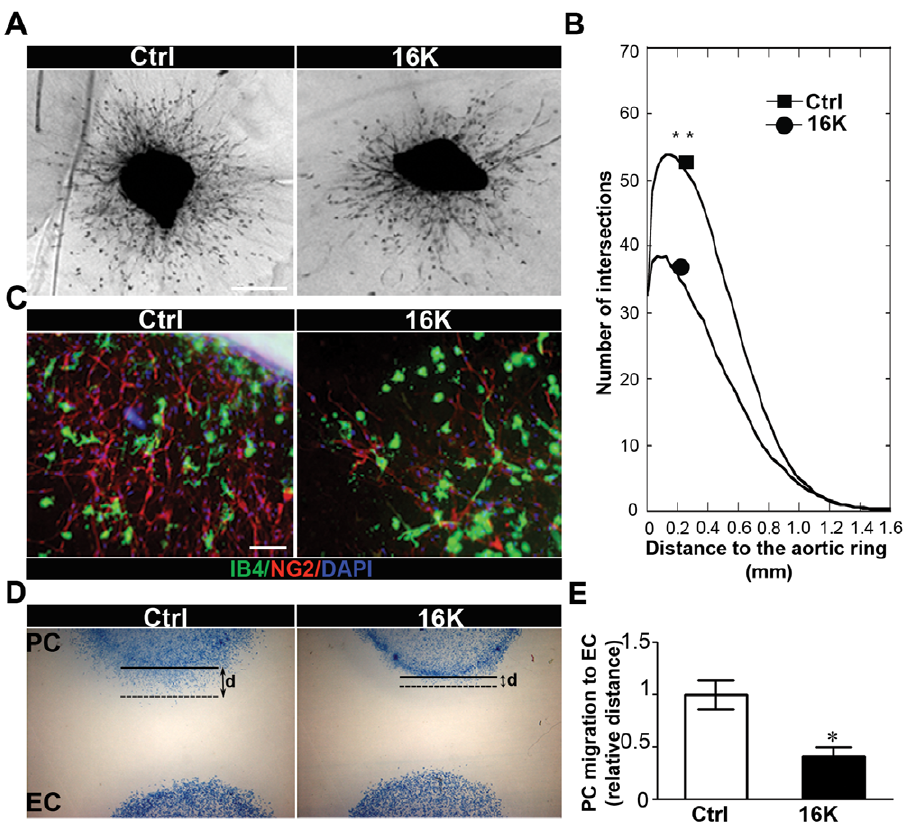
Figure 3. 16K hPRL inhibits pericyte outgrowth in an aortic ring assay and pericyte migration towards endothelial cells. (A) Photomicrographs of mouse aortic ring cultured in collagen for 9 days and incubated without specific treatment (Ctrl) or under 16K hPRL treatment (16K). Data representative of at least 2 independent experiments are shown. Bar , 1 mm. (B) Quantification of migrating cell distribution around the aortic ring performed by computerized image analysis. Cell distribution is defined as the number of intersections between spreading cells and a grid of concentric rings, plotted as a function of the distance to the aortic fragment. Each curve is a mean of the cell network distribution obtained by averaging at least 5 individual distributions generated for each experimental condition. (C) Photomicrographs of a mouse aortic ring cultured in collagen for 9 days without specific treatment (Ctrl) or in the presence of 100 nM 16K hPRL. The rings were fixed for subsequent immunostaining: anti-Isolectin B4 Ab (IB4: green) identifying EC, anti-NG2 proteoglycan Ab (NG2: red) identifying PC/SMC. Nuclei were colored with DAPI (blue). Data representative of at least 2 independent experiments are shown. Bar , 100 m m. (D) HBVP migration towards HUVEC was assessed in an under-agarose migration coculture assay. HUVEC were treated for 72 h with 100 nM 16K hPRL (16K). d=migration distance between the beginning (solid line) and the end of the migration (dotted line). *, P , 0.05.